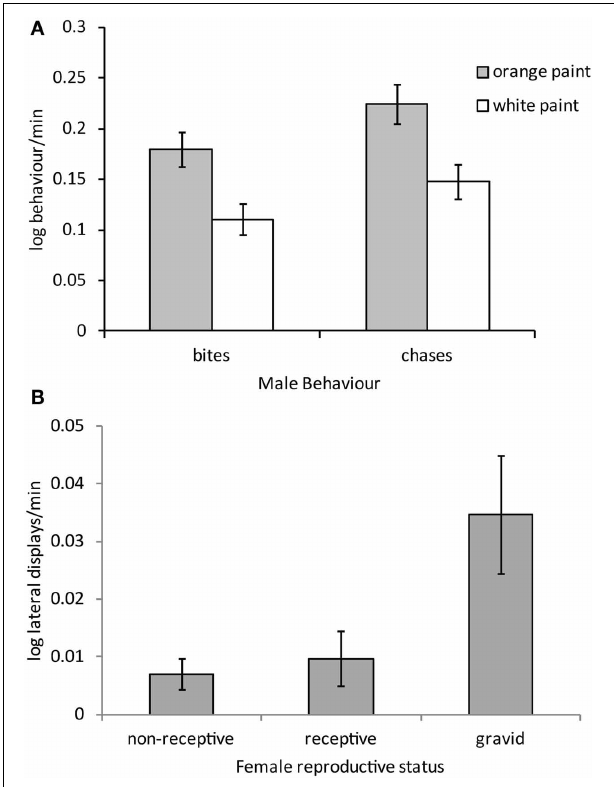
FIGURE 4 | Mean ( ± SE ) (A) male harassment behavior performed to orange and white painted females and (B) male aggressive behavior toward females in different reproductive stages (regardless of color). Males bit and chased orange females significantly more than white females P < 0 . 05 for both cases (see